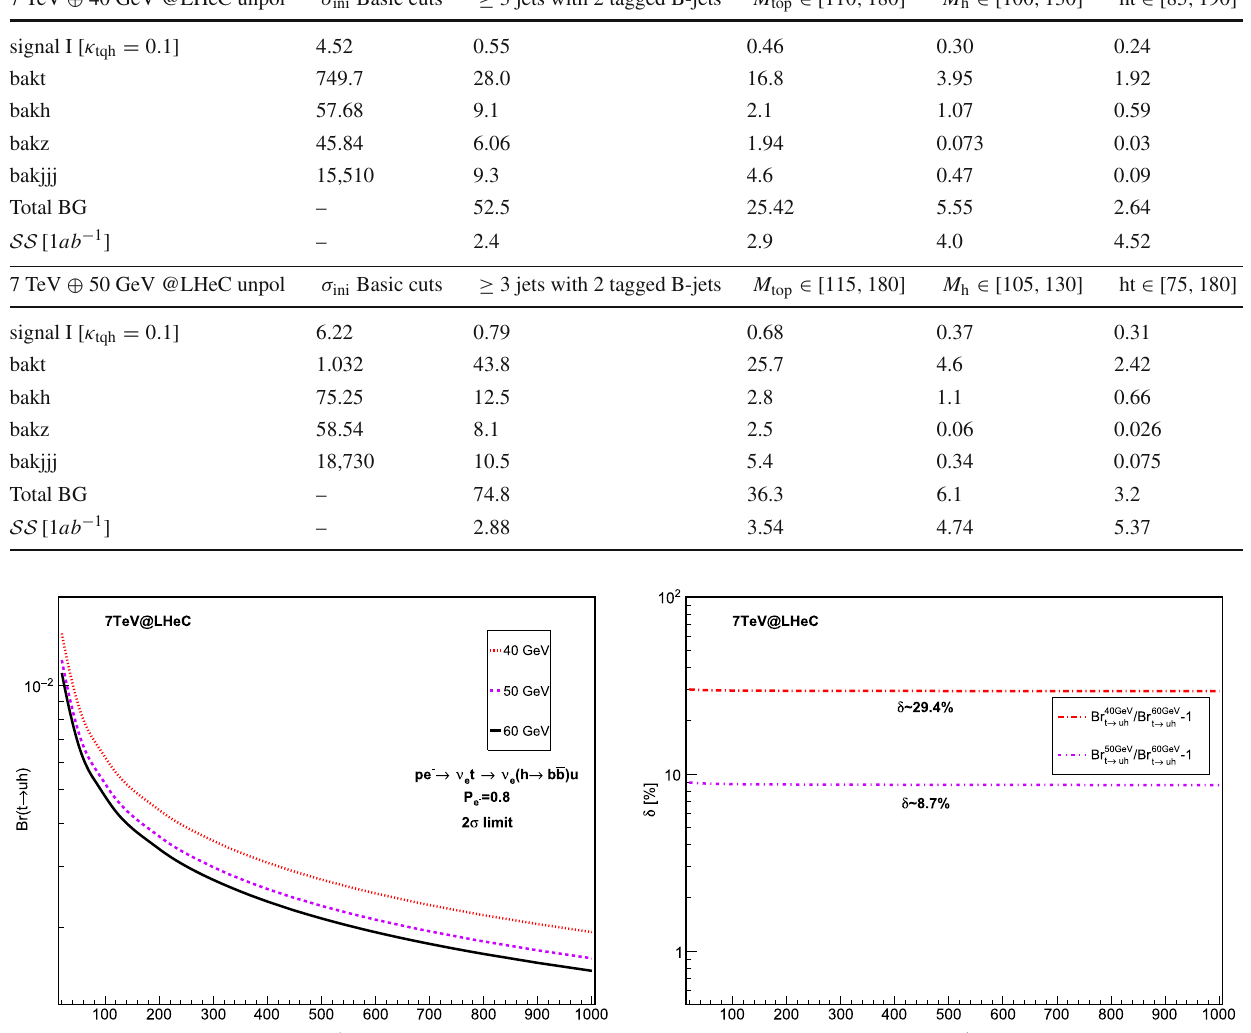
Table 3 Cross sections (in units of fb) and significance depending on the cut flows for signal I e − p → ν e ¯ t → ν e h ¯ q → ν e b ¯ b ¯ q ( κ tuh = 0 . 1) and backgrounds at the 7 TeV ⊕ 40 GeV @LHeC and 7 TeV ⊕ 50